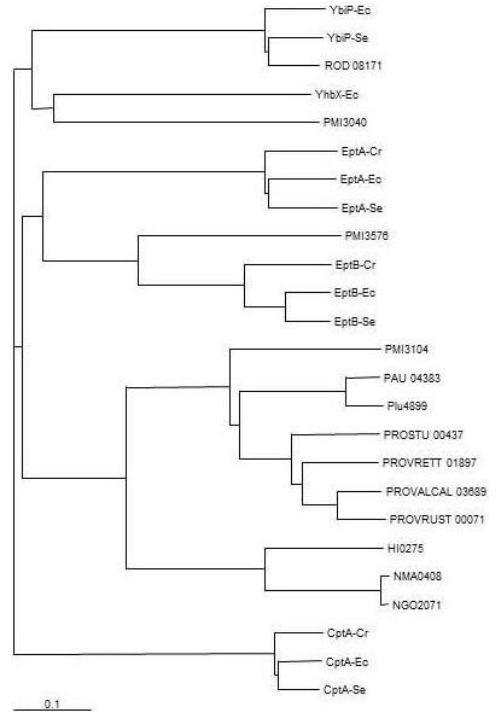
Figure 2. Phylogenetic tree of selected known and putative PEtN transferases. Shown are proteins from P. mirabilis HI4320 (PMI3040, PMI3576, PMI3104 [ eptC ]), E. coli MG1655 (YbiP-Ec, YhbX-Ec, CptA-Ec, EptA-Ec, EptB-Ec), S. enterica LT2 (YbiP-Se, CptA-Se, EptA-Se, EptB-Se), Citrobacter rodentium ICC168 (ROD 08171, CptA-Cr, EptA-Cr, EptB-Cr), Photorhabdus asymbiotica asymbiotica ATCC 43949 (PAU 04383), Pho. luminescnes laumondii TT01 (Plu4899), Providencia stuartii ATCC 25827 (PROSTU 00437), Providencia rettgeri DSM 1131 (PROVRETT 01897), Providencia alcalifaciens DSM 30120 (PROVALCAL 03689), Providencia rustigianii DSM 4541 (PROVRUST 00071), Haemophilus influenzae Rd KW20 (HI0275), Neisseria meningitidis Z2491 (NMA0408), and N. gonorrhoeae FA 1090 (NGO2071). Note: The separation and the size of the lanes are relative to the similarity degree according to the program used (the scale bar indicates an evolutionary distance of 0.1 amino acid substitutions per